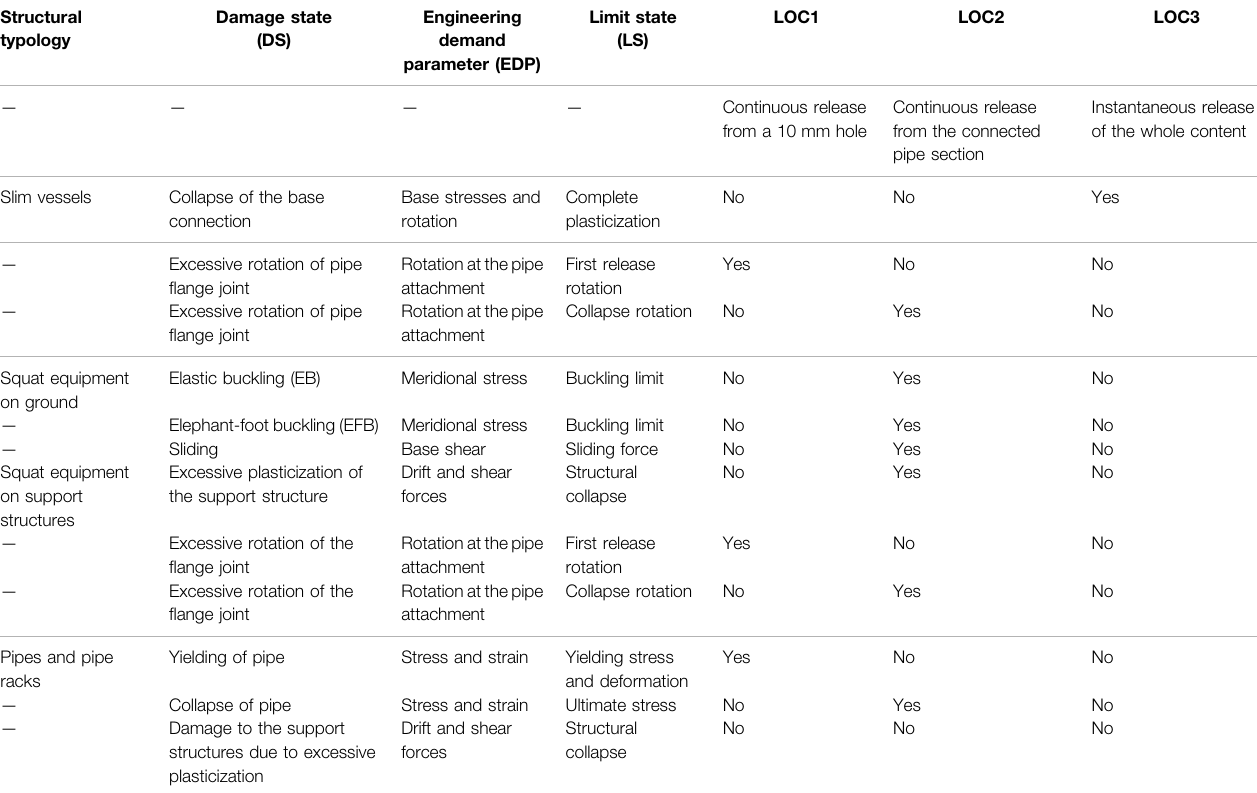
TABLE 3 | Vulnerability classes of process plant equipment. Structural